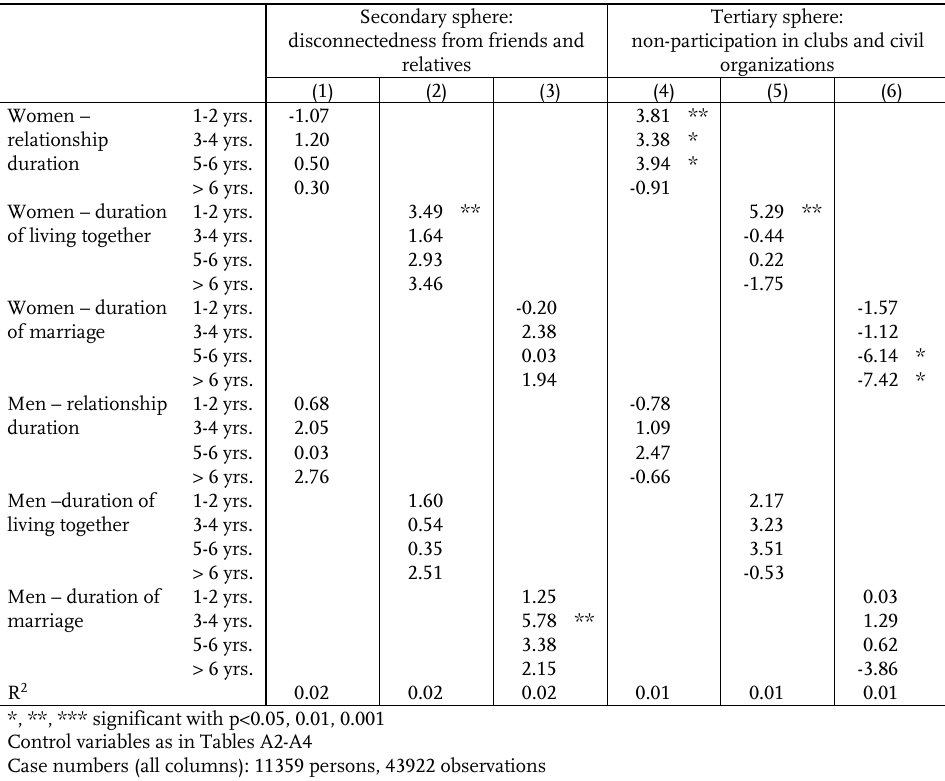
Tertiary sphere: non-participation in clubs and